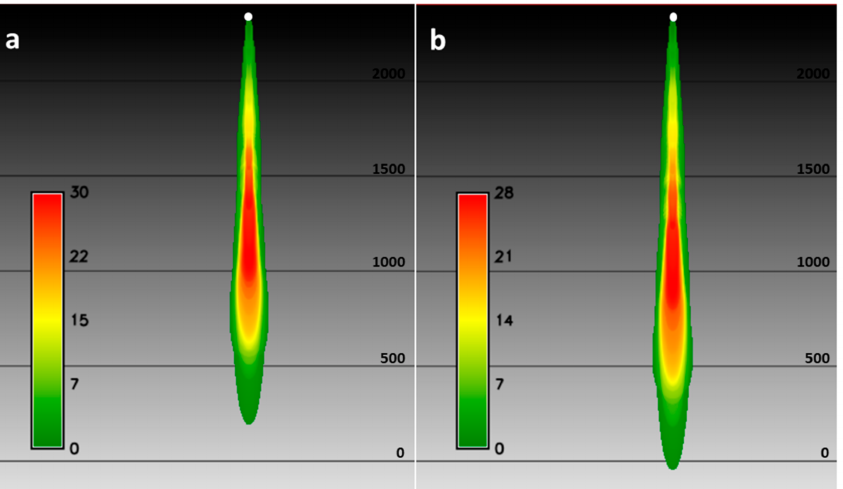
Figure 12. Final lava flow emplacements simulated by GPUFLOW on a 20-degree inclined DEM using ( a ) constant emissivity of 0.9 and ( b ) temperature-dependent emissivity. Colours represent the thickness of lava in meters, as reported in the legends. The white point indicates the flow start position, whereas the black lines represent the contours of altitude (500 m intervals, from 2000 m to 0